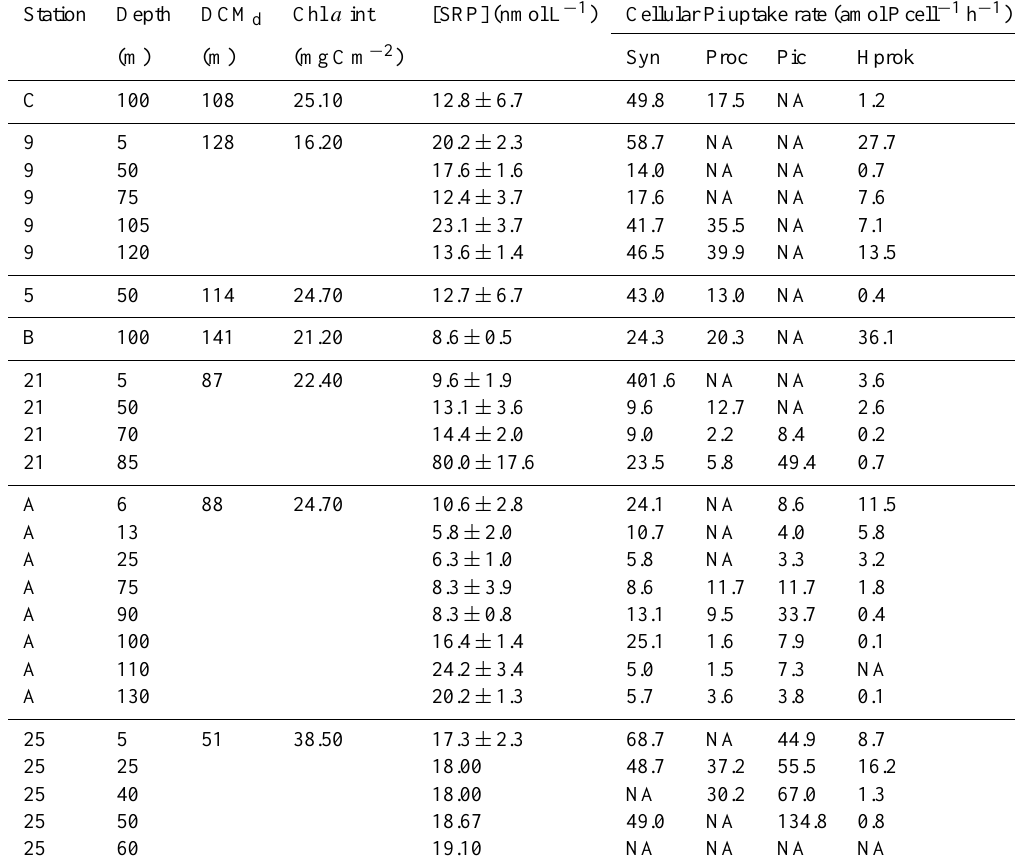
Table 1. Environmental context of the experiments: sampled depth (m), depth of the deep chlorophyll maximum (DCM d ), 0–150m integrated Chl a concentrations, SRP concentrations (mean ± SD), and cellular rates of Pi uptake measured in sorted groups Synechococcus (Syn), Prochlorococcus (Proc), picoeukaryotes (Pic) and heterotrophic prokaryotes (Hprok) measured under ambient concentrations. NA: data not